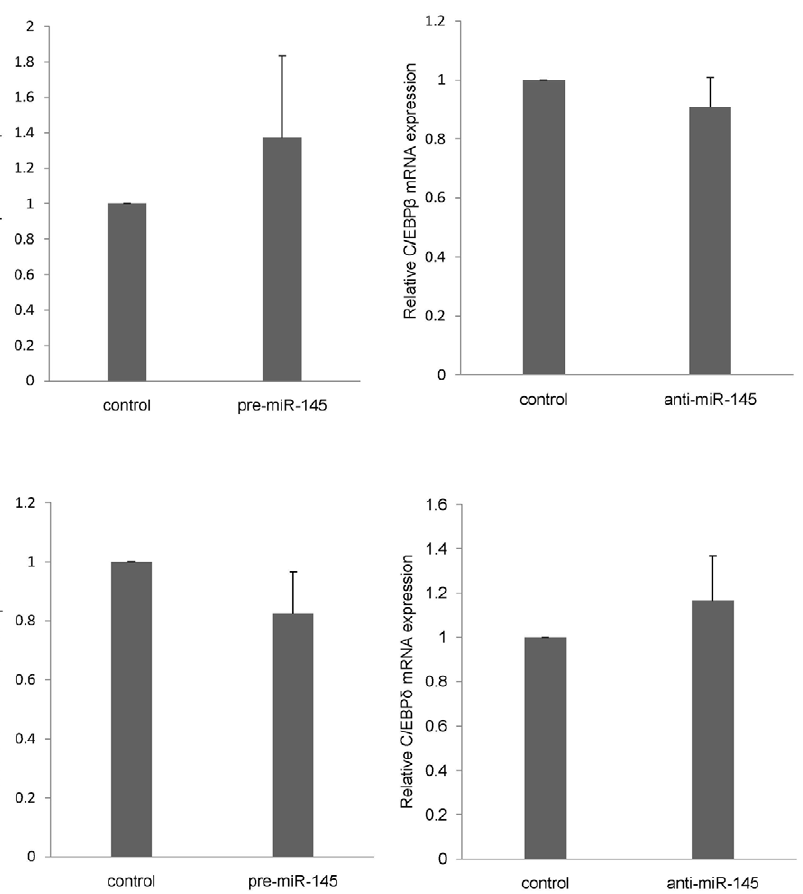
Figure 6. Mir-145 has no influence on mRNA expression of C/EBP b and C/EBP d . C3H10T1/2 cells were transfected with pre-miR145, anti- miR-145 or its control, respectively. After 24 h of treatment with TGF- b 3, all of cells were lysed. The expression of C/EBP b and C/EBP d were measured via qRT-PCR. The relative expression level of mRNA in cells transfected with control oligonucleotide was set to one, as control. Three independent cell culture experiments were done and data was represented as mean 6 sd. *, p , 0.05, when compared with